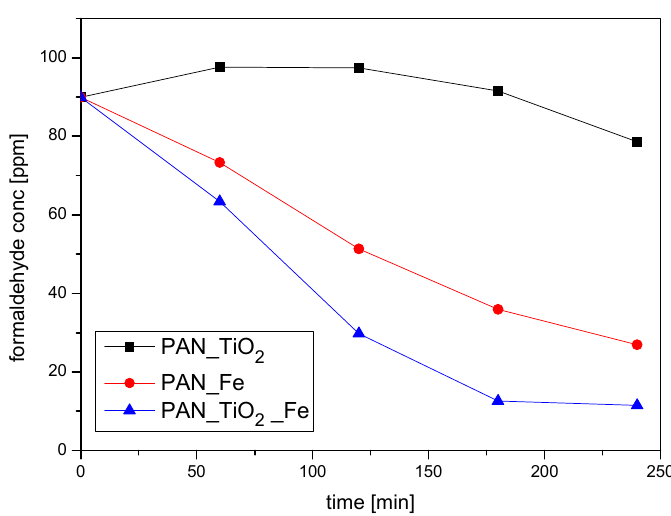
Figure 8. Formaldehyde concentration profile using heterogeneous photo-Fenton (PAN_Fe), photocatalytic (PAN_TiO 2 ) and their combination (PAN_TiO 2 _Fe) catalysts. The maximum standard deviation of the experimental points was 1.9 ppm.